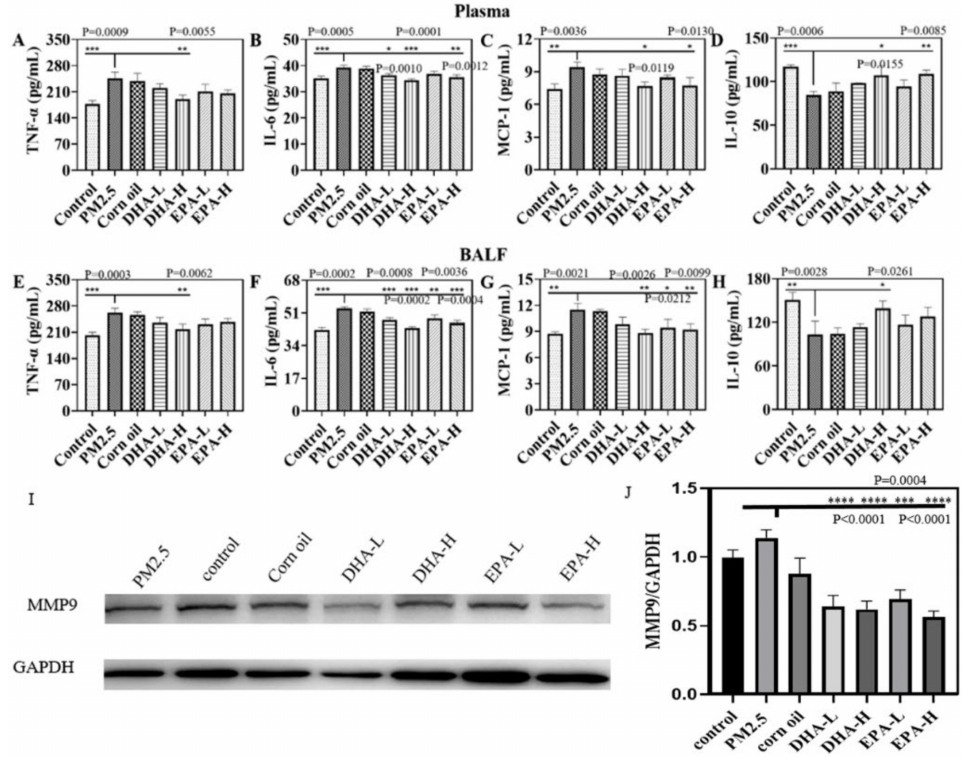
Figure 4. The changes of cytokines in plasma and BALF after PM2.5 exposure and treatment with different doses of DHA or EPA. ( A – D ) IL-6, TNF- α , MCP-1, IL-10 in plasma. ( E – H ) IL-6, TNF- α , MCP-1, IL-10 in BALF. Data are expressed as the mean ± SD. **** p < 0.0001, *** p < 0.001, ** p < 0.01, * p < 0.05. The control mice have received the oral gavage of saline without PM2.5 exposure. The mice in the corn oil group were with PM2.5 exposure and orally administered with corn oil. The MMP-9 expression in the lung after PM2.5 exposure and gavage with different doses of DHA or EPA were detected by the Western blot ( I ) and blot quantification ( J